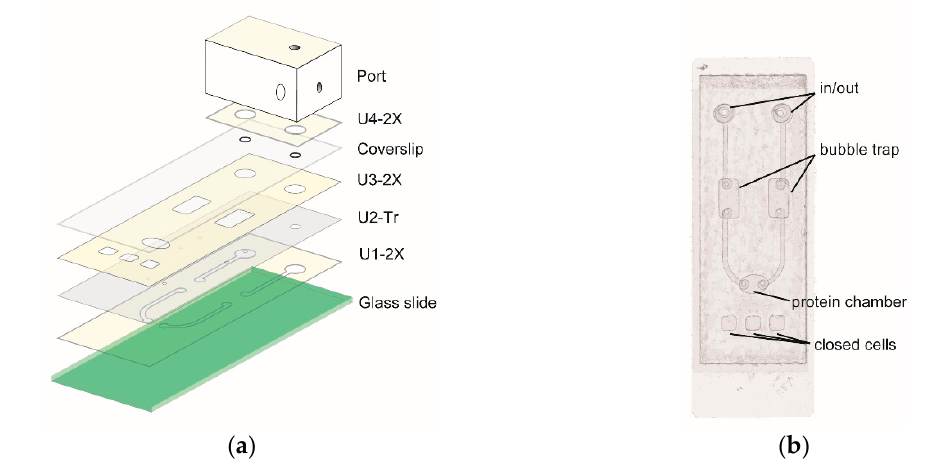
Figure 2. Microfluidic protein chip. ( a ) Scheme of laying units of double adhesive films (2X), transparency film (Tr), coverslip, and port on the glass slide. ( b ) An assembled chip (top view).